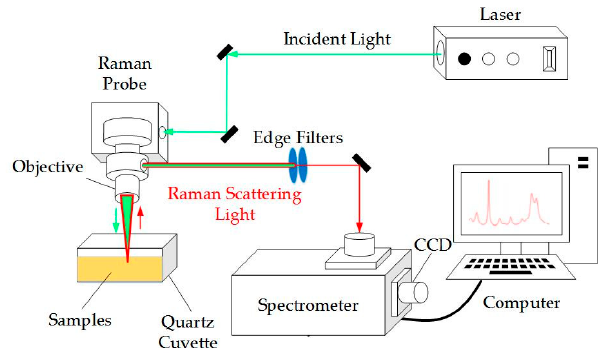
Figure 1. Schematic diagram of oil-dissolved solution detection platform basing on Raman spectroscopy.